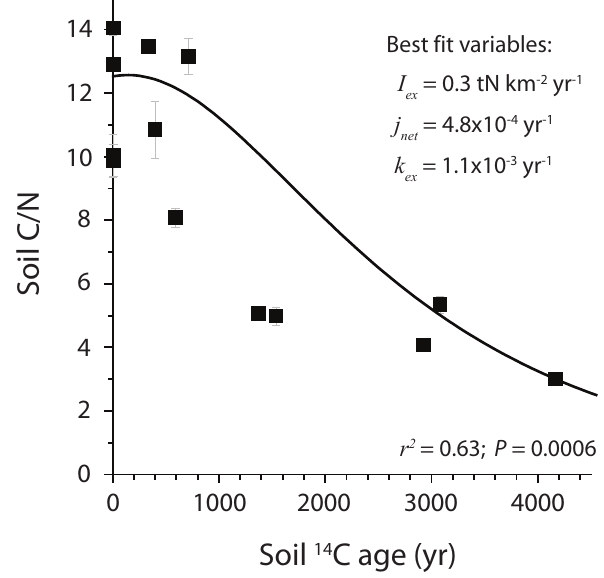
Fig. 4. C/N and 14 C age for soil organic matter from the Cen- tral Range, Taiwan. Analytical uncertainty is indicated by grey whiskers if larger than the point size. A mass balance model (black line, Eqs. 1 and 3) describes the first-order trend in the data and predicts an integrated average N loss rate constant ( k ex ) across the dataset, with a minimum misfit parameterisation as shown ( r 2 = 0.63; P =